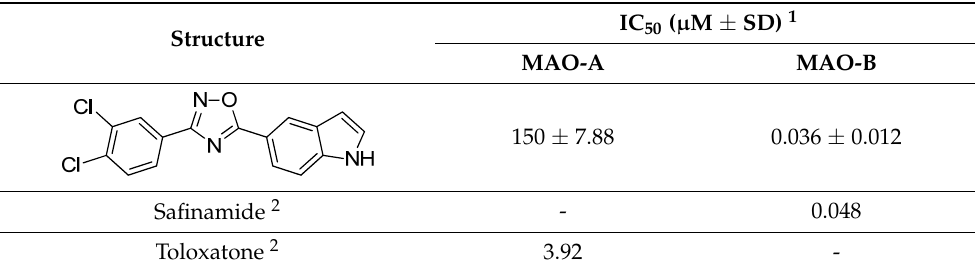
Table 1. The inhibition of human MAO-A and MAO-B by 3-(3,4-dichlorophenyl)-5-(1 H -indol-5-yl)- 1,2,4-oxadiazole 4 .